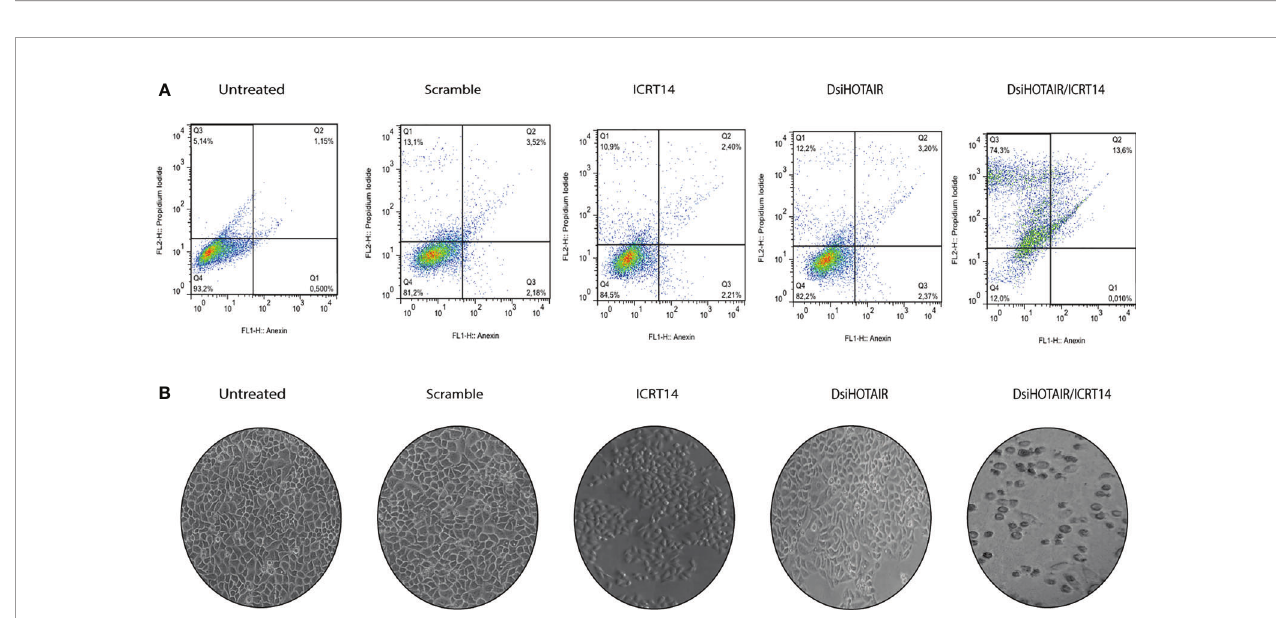
FIGURE 7 | DsiHOTAIR plus ICRT14 induces cell death by necrosis in HeLa cells (A) Flow cytometry percentage distributions after annexin V/propidium iodide staining of HeLa incubated with the scramble, DsiHOTAIR (30 µM), ICRT14 (12.9 µM) and the combination DsiHOTAIR/ICRT14. (B) Representative images of HeLa cells incubated with the scramble, DsiHOTAIR, ICRT14; and the combination DsiHOTAIR /